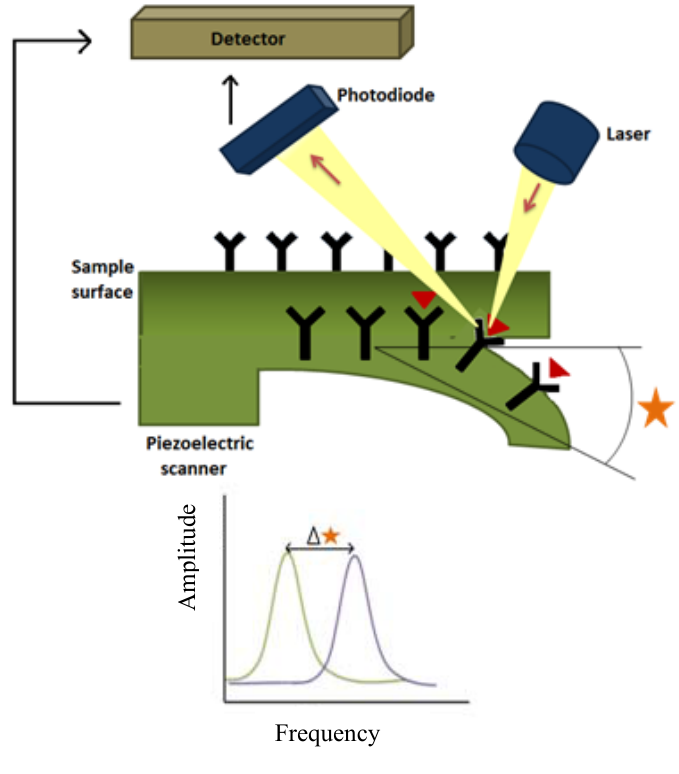
Figure 4. Schematic description of microcantilevers detection systems used in biomarkers